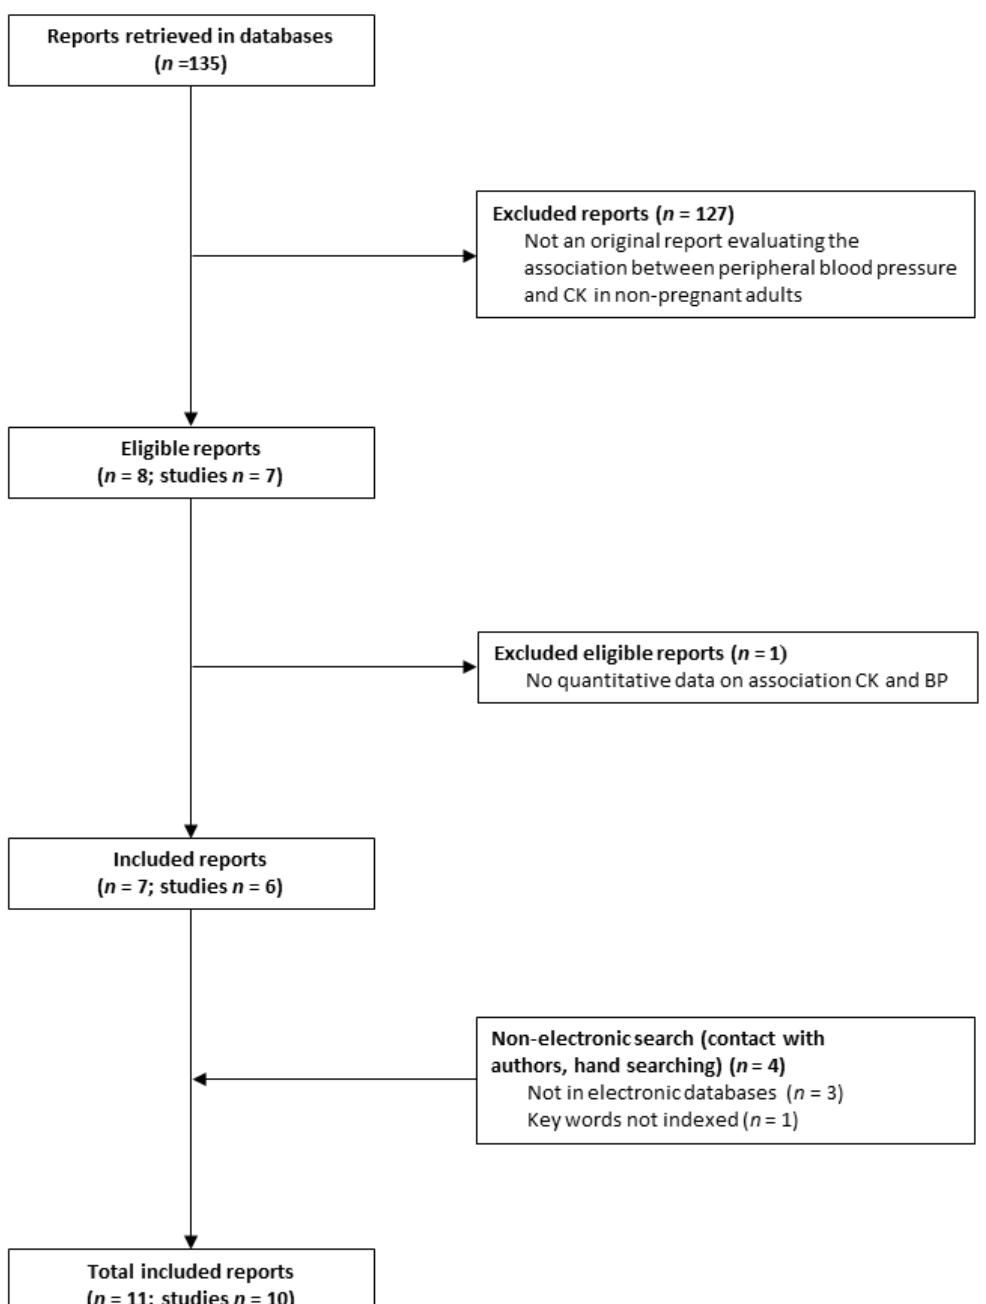
Figure 2. Paper Flow. The figure depicts the number of retrieved, eligible, and included reports and the yield of the hand search. The 11 included papers are reports from 10